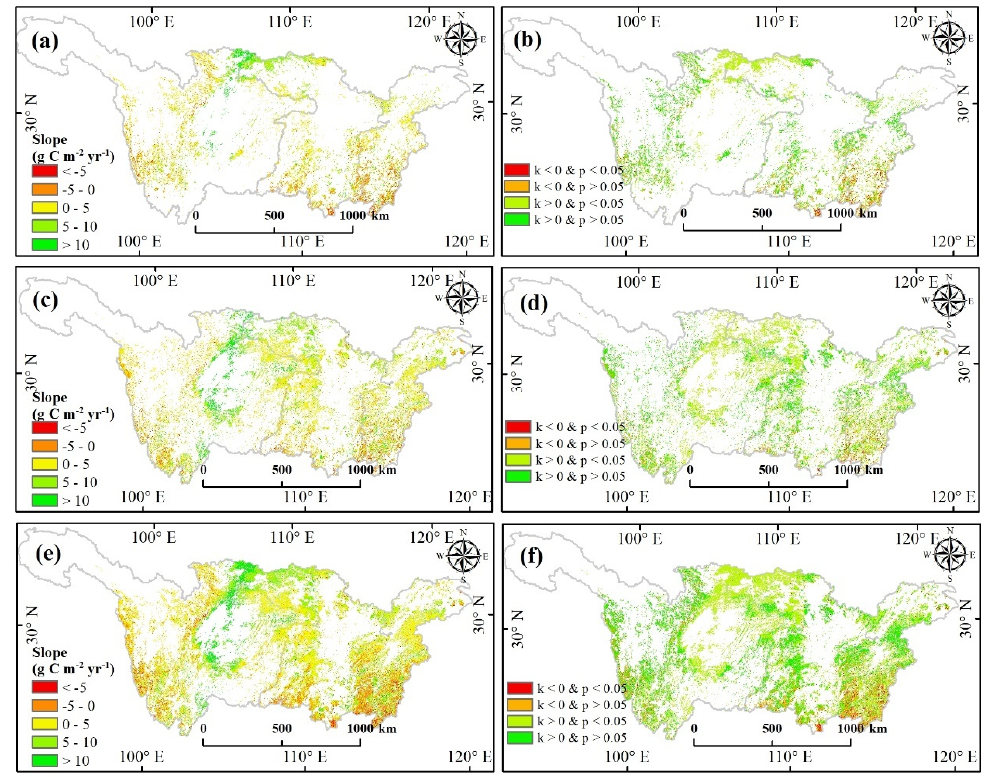
Figure 5. Net primary productivity (NPP) trend of ( a ) the old forest, ( c ) the new forest, and ( e ) all forest, ( b , d , f ) their corresponding